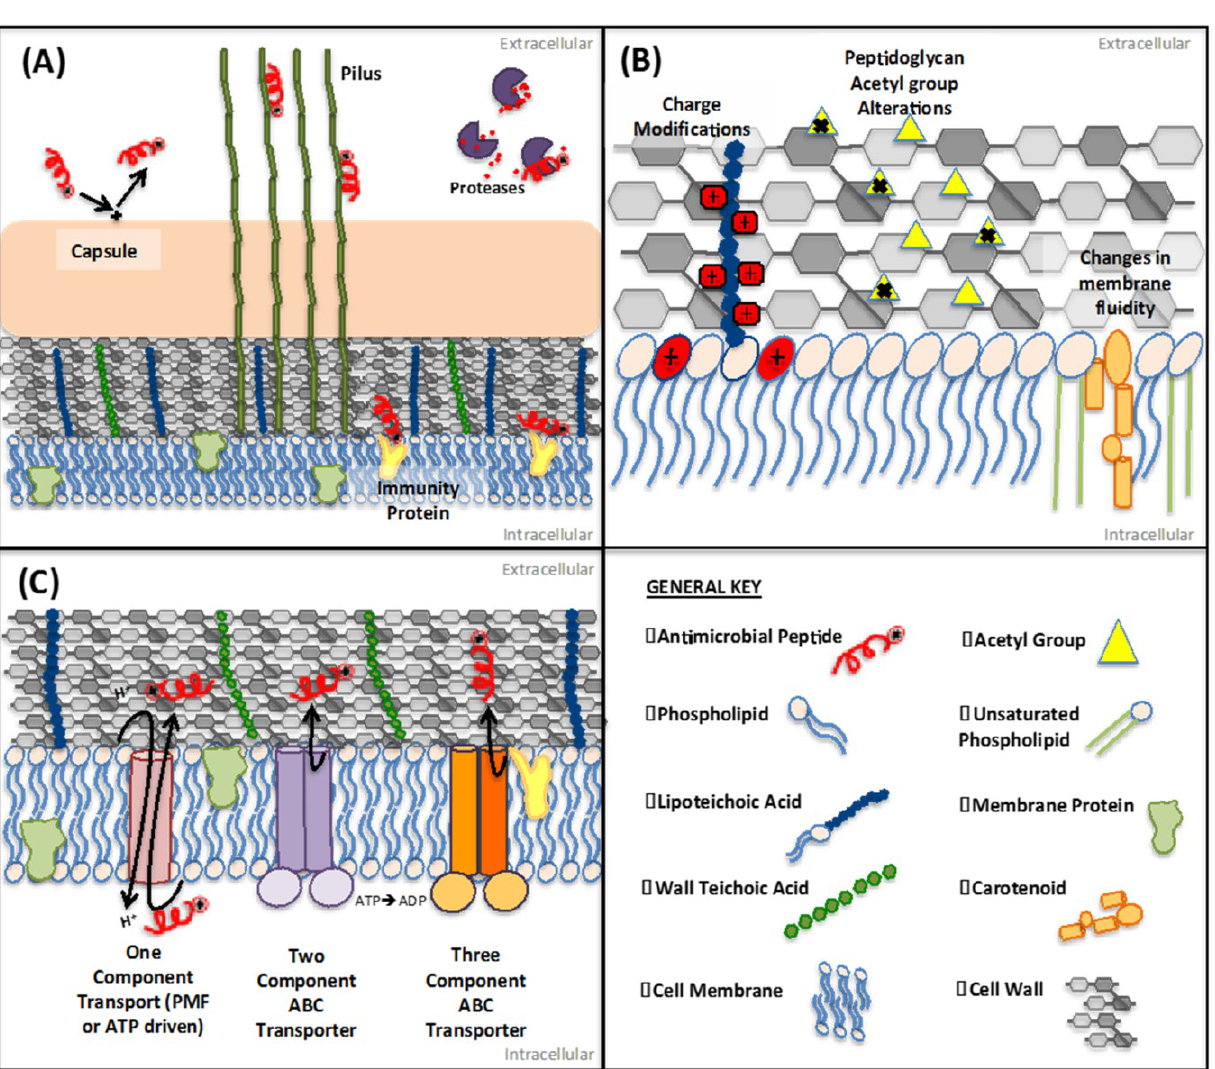
Figure 1. Overview of Antimicrobial Peptide Resistance Mechanisms in Gram-Positive Bacteria. ( A ) Extracellular mechanisms of AMP resistance include peptide degradation by secreted proteases, AMP sequestration by secreted or membrane associated protein (e.g., pili, immunity proteins, M proteins), or blocking by capsule polysaccharides; ( B ) Cell wall and membrane modifications include: Alteration of charge by lysination of the phospholipid head groups or D -alanylation of the lipoteichoic backbone, modification of the cell wall by deacetylation of N-acetylglucosamine or O-acetylation of N-acetylmuramyl residues, and alterations in membrane fluidity by phospholipid tail saturation or carotenoid additions; ( C ) Transport mechanisms of antimicrobial efflux from the cell include: ATP-driven ABC transporters composed of a single, double, or triple protein pump and involve a supplementary immunity protein, or single protein transporters driven by proton motive